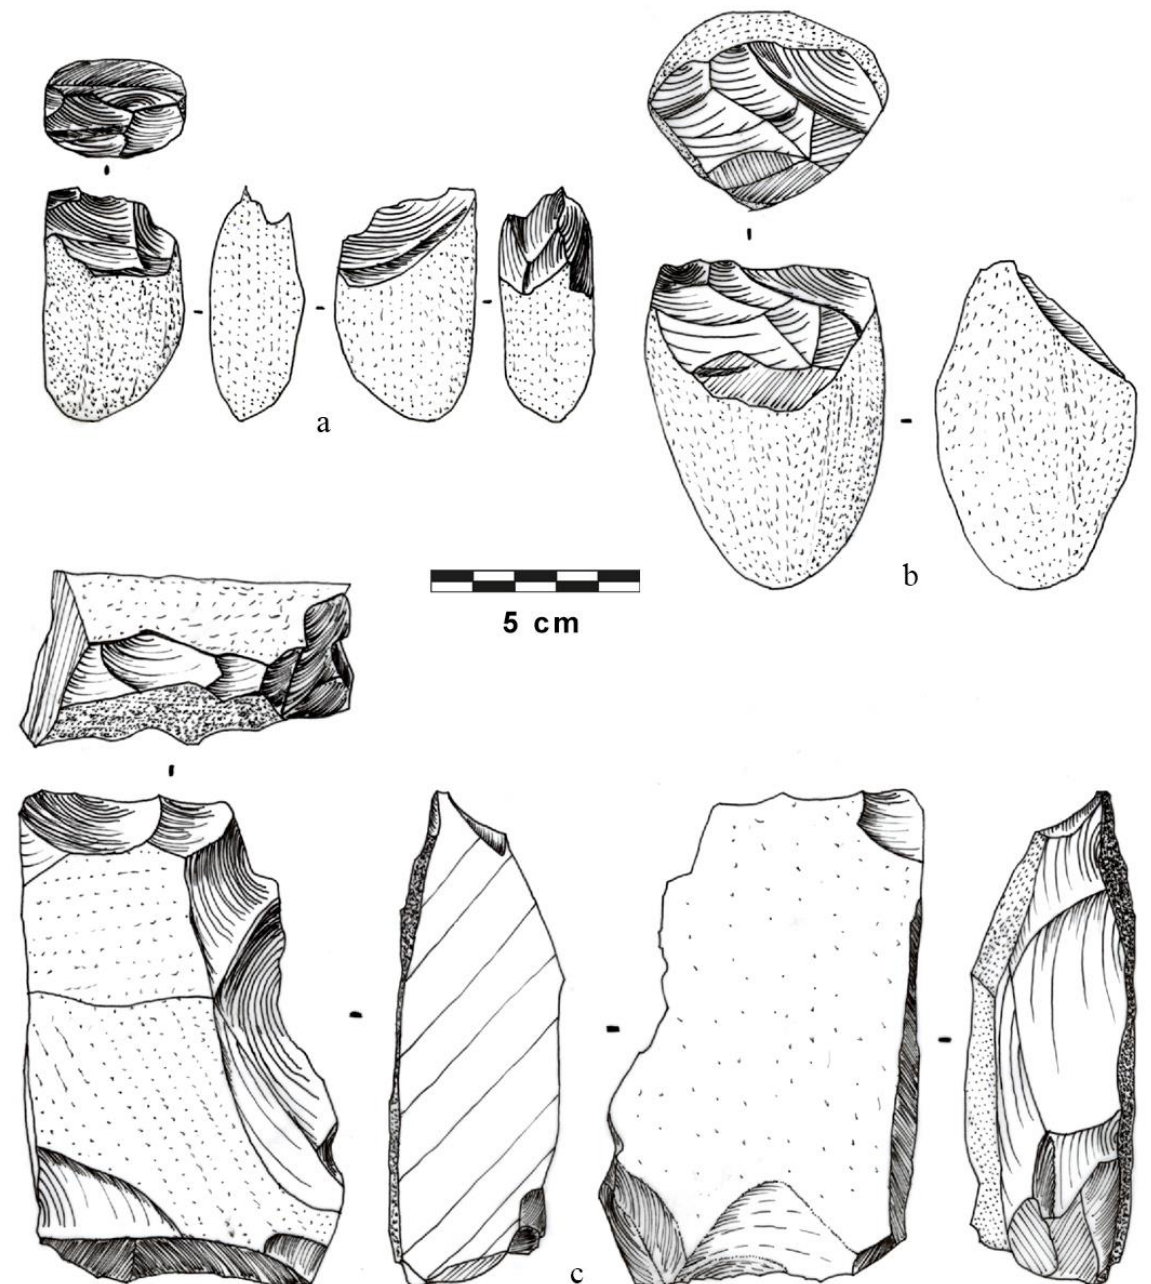
Figure 18. Tools on pebbles (a; b) and slab (c), transformative part shaped on an